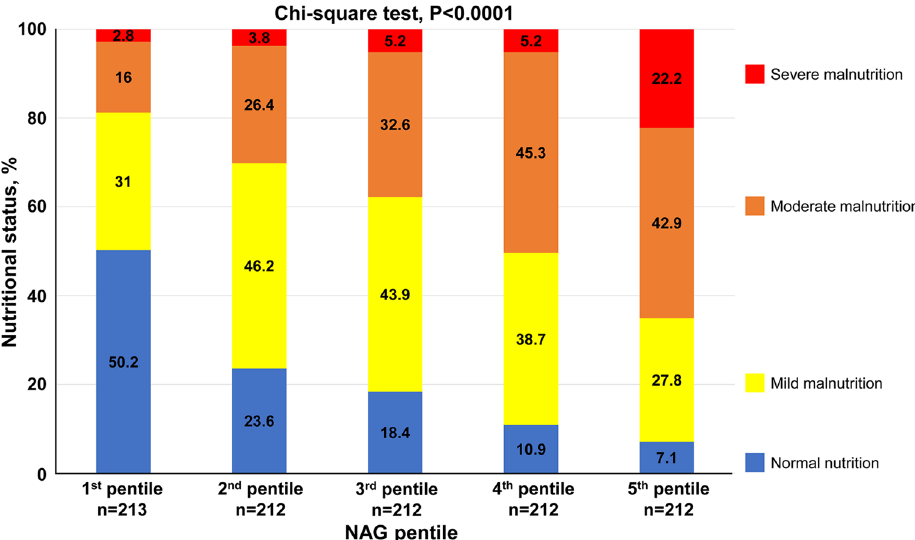
Figure 3. Association between malnutrition severity and renal tubular damage severity.